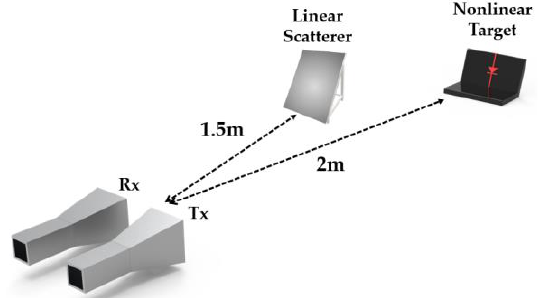
Figure 12. Nonlinear FMCW radar measurement setup with a linear scatterer.